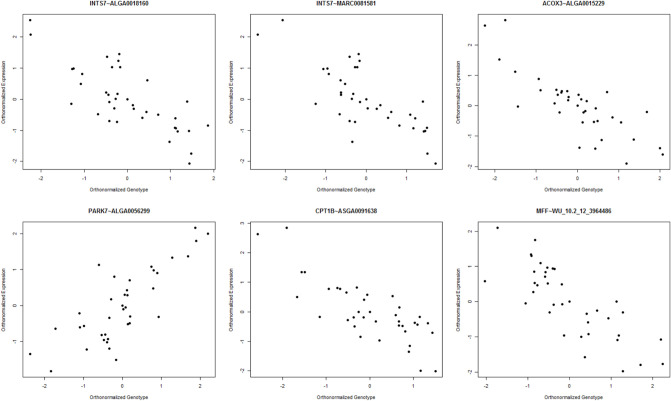
Orthonormalized expression and genotypes of top eQTLs.Scatter-plot of the orthonormalized expression and genotype values for the top 6 trans-eQTLs in the linear analysis. The linear relationship is quite clear on the transformed values, in comparison to the boxplots of the untransformed values.